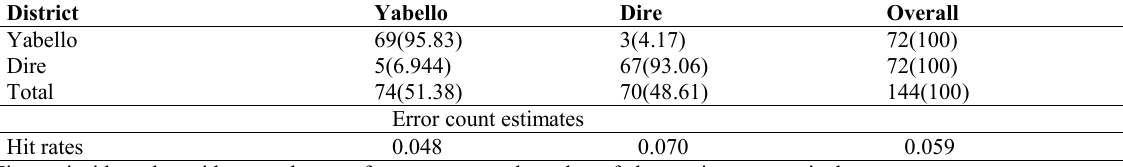
Figures inside and outside parentheses refer to percent and number of observations respectively. Table 7. Squared Mahalanobis distance between districts for the females above diagonal and males below diagonal of sampled local chicken populations.